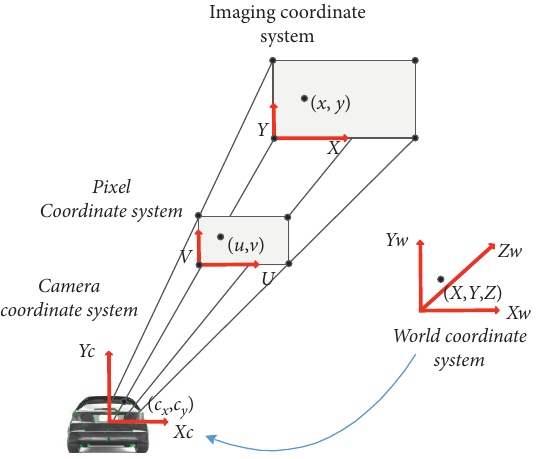
Figure 3: Schematic diagram of coordinate